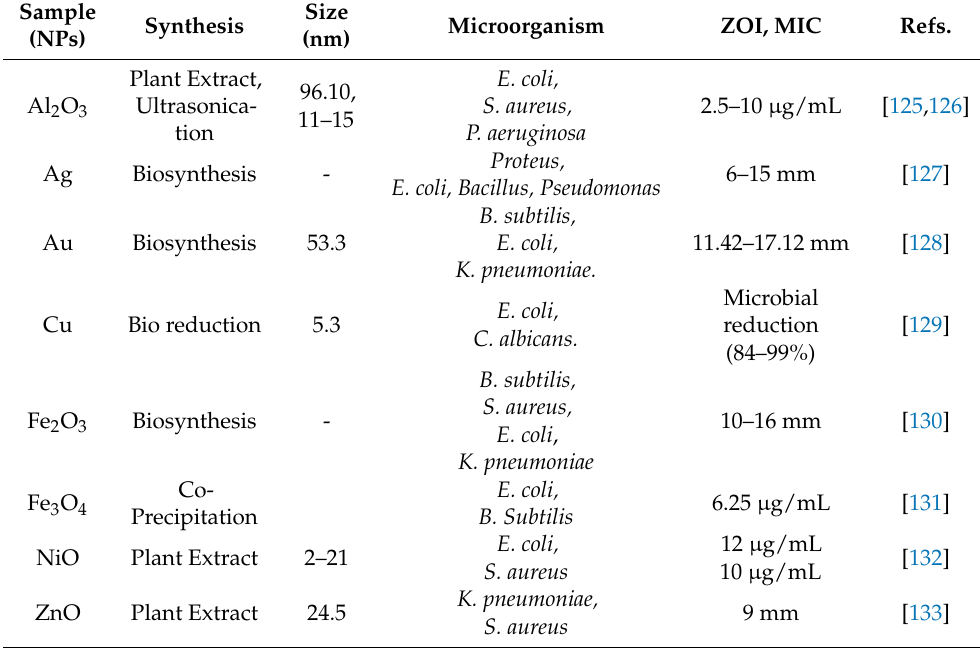
Figure 7. (Panel [ A ]): Determination of ZOI for copper oxide NPs synthesized via mechanochemical method using CuSO 4 · 5H 2 O and CuCl 2 · 2H 2 O for treating E. coli and S. aureus bacteria; insets [a] gentamicin antibiotics and [b] copper oxide treated discs in the antimicrobial study. (Panel [ B ]): Determination of MIC and MBC through CFU against S. aureus . (Reproduced with permission from Ref. [121]. Copyright © 2019 Elsevier B.V. All rights reserved). Table 2. Antimicrobial properties of various metal and metal oxide